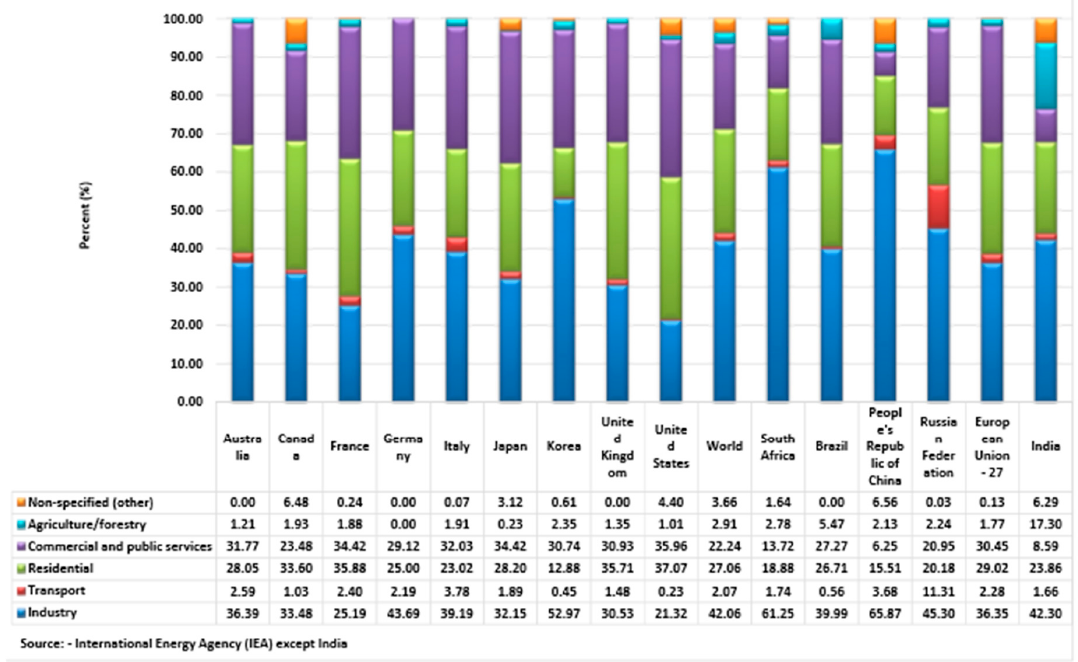
Figure 5. Category-wise % Shares in Electricity Consumption across various countries (2015).